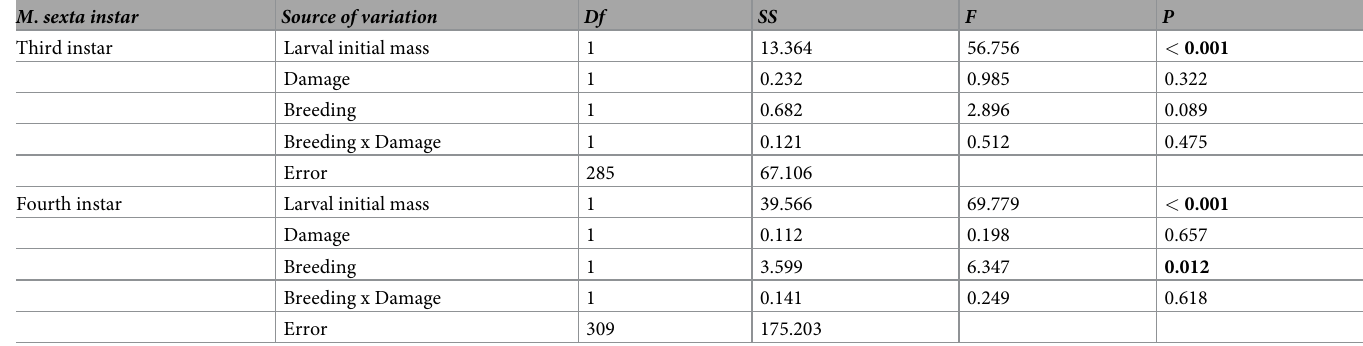
P values < 0.05 are in boldface.